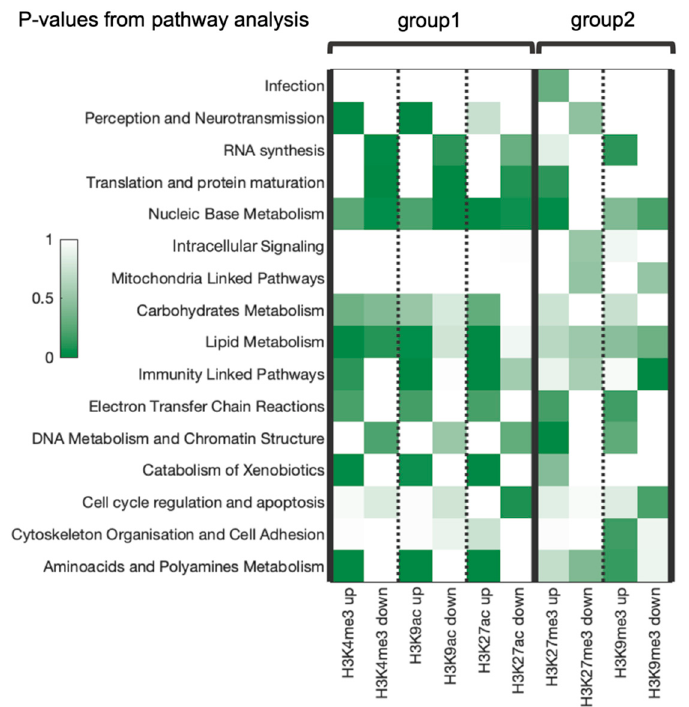
Figure 6. EASE Scores (modified Fisher exact P-values) heatmap for association with RRE up- or down regulation for each functional category for five histone tags under study. Up/down means enrichment/deficiency, respectively.